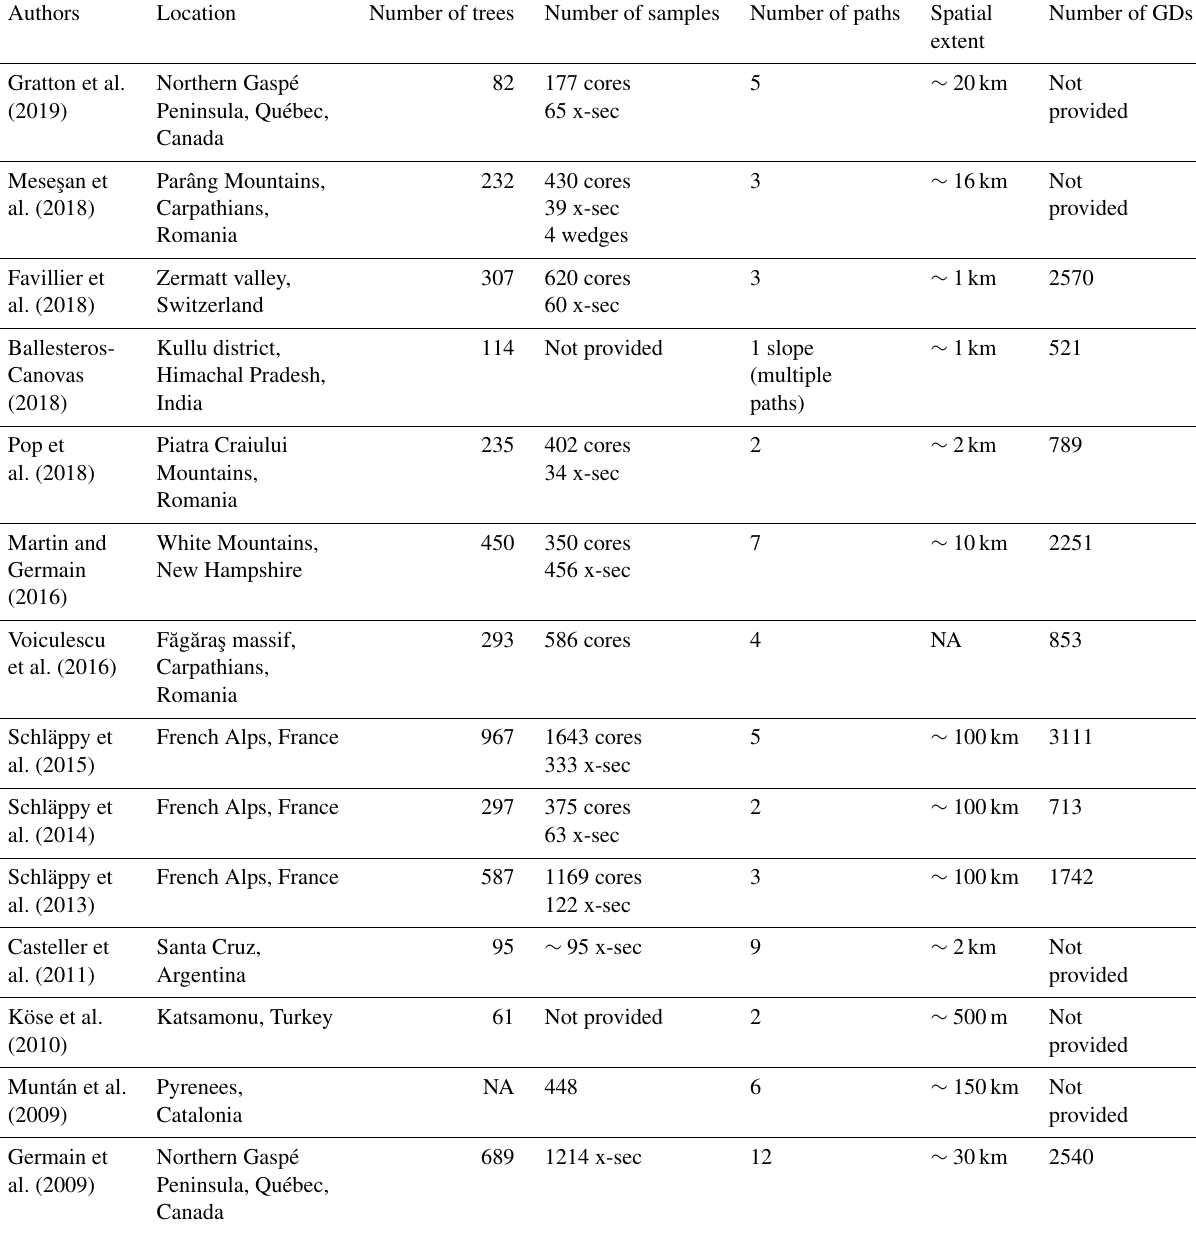
Table A1. List of previous avalanche dendrochronological studies with more than one avalanche path to place our regional work in context with other regional/multiple path studies. Number of samples, paths, growth disturbances (GDs), and spatial extent (linear distance between most distant avalanche paths in study area) are included. For spatial extent, NA is reported in studies in which spatial extent is not reported or could not be inferred from maps in the published work. When spatial extent is not reported directly in previous work, it is estimated by using maps from the published work and satellite imagery. We included only the initial studies using a dataset with more than one avalanche path. For example, if a study used the same dataset again in subsequent work, we did not include